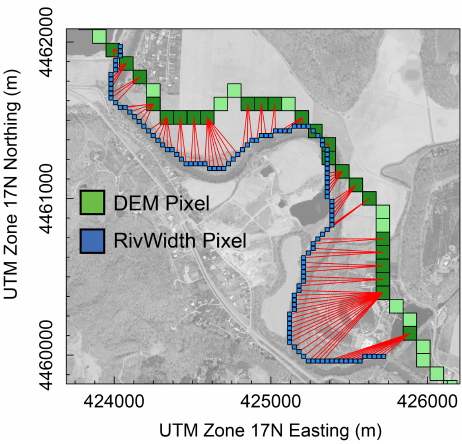
Figure 3. Linking RivWidth and DEM measurements: RivWidth measurements for the Walhonding River near Coshcocton, PA, matched to the nearest downstream DEM-derived channel pixels with drainage area values.